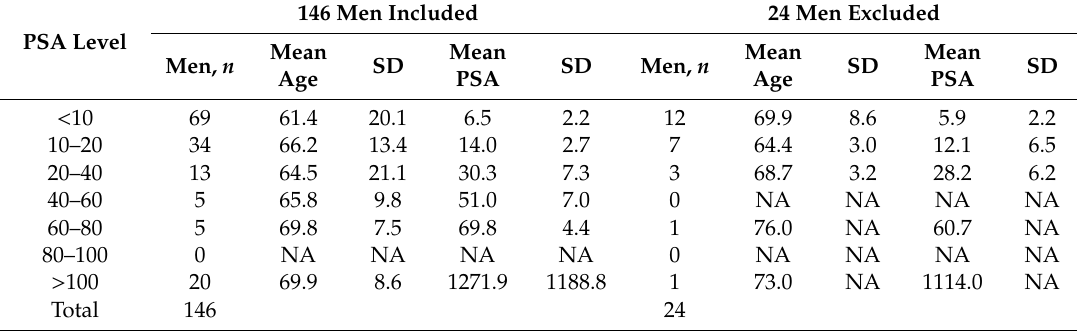
Table 1. Baseline characteristics of 170 men enrolled. PSA: prostate-specific antigen. NA: not applicable.